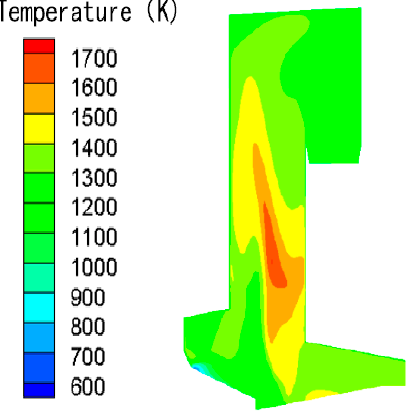
Figure 7. Temperature on the middle plane.